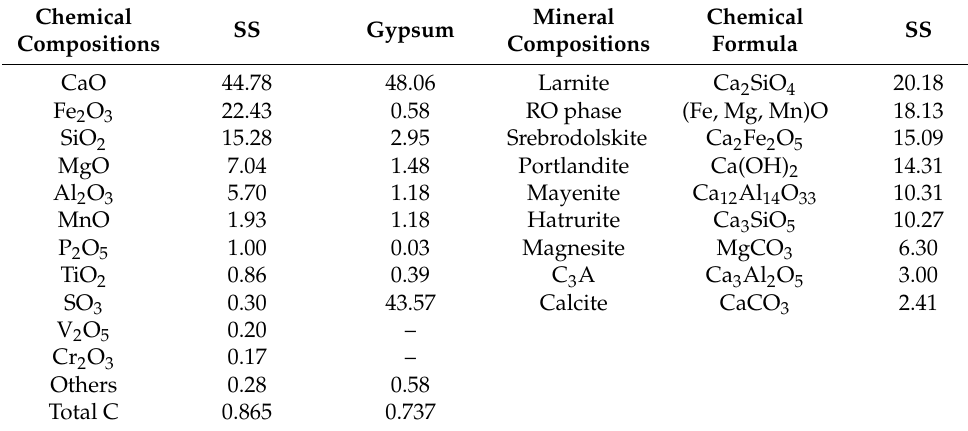
Table 1. Chemical compositions of the SS and DG